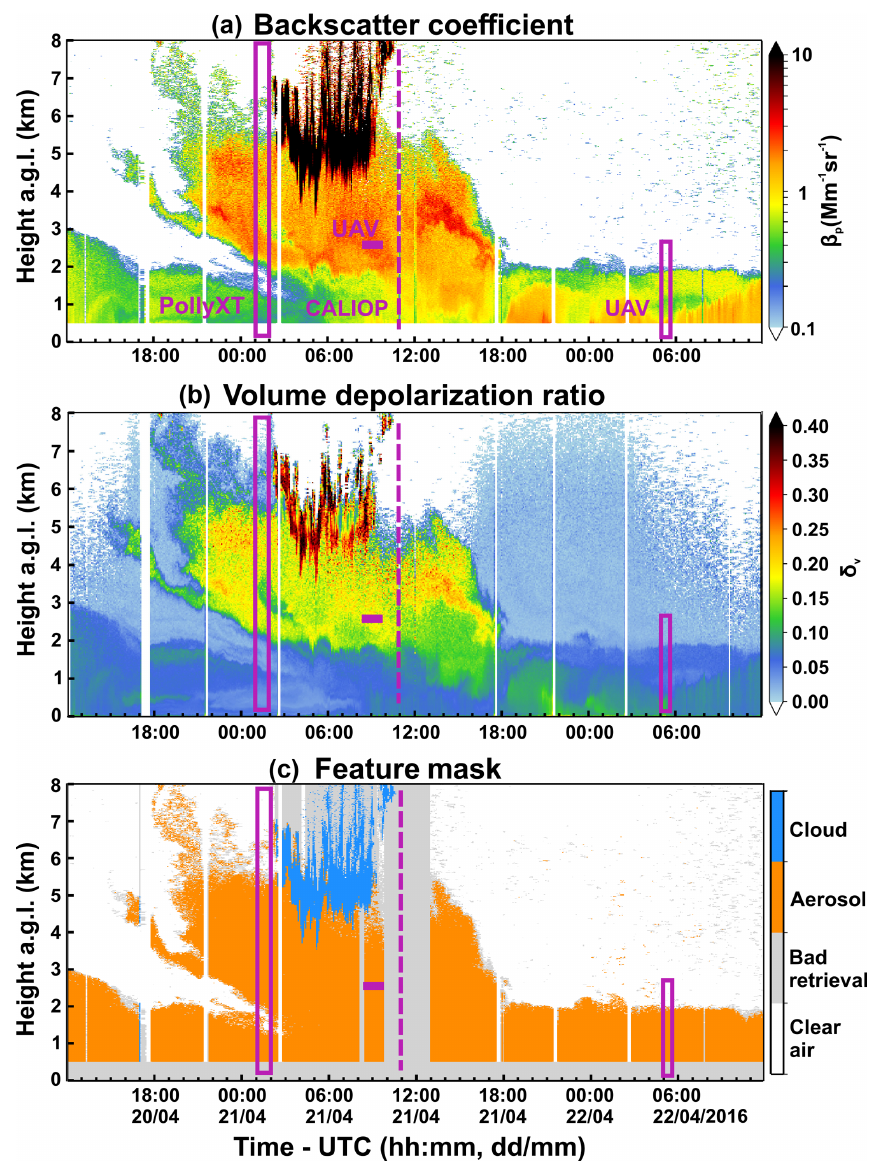
Figure 4. Time–height PollyXT observations between 12:00UTC on 20 April 2016 and 12:00UTC on 22 April 2016 of the backscatter coefficient at 1064nm (a) , the volume linear depolarization ratio at 532nm (b) and the feature mask (c) . The magenta markers refer to the analyzed periods of PollyXT (left box: 01:00–02:00UTC on 21 April 2016), CALIOP (dashed line: 11:01UTC on 21 April 2016) and UAV (horizontal bar: INP sampling between 08:30 and 09:40UTC on 21 April 2016; right box: OPC measurements between 05:00 and 05:30UTC on 22 April 2016) that are being referred to in this study. The bad retrievals in the feature mask refer to observations affected by (i) total attenuation due to clouds, (ii) low signal-to-noise ratio and (iii) incomplete